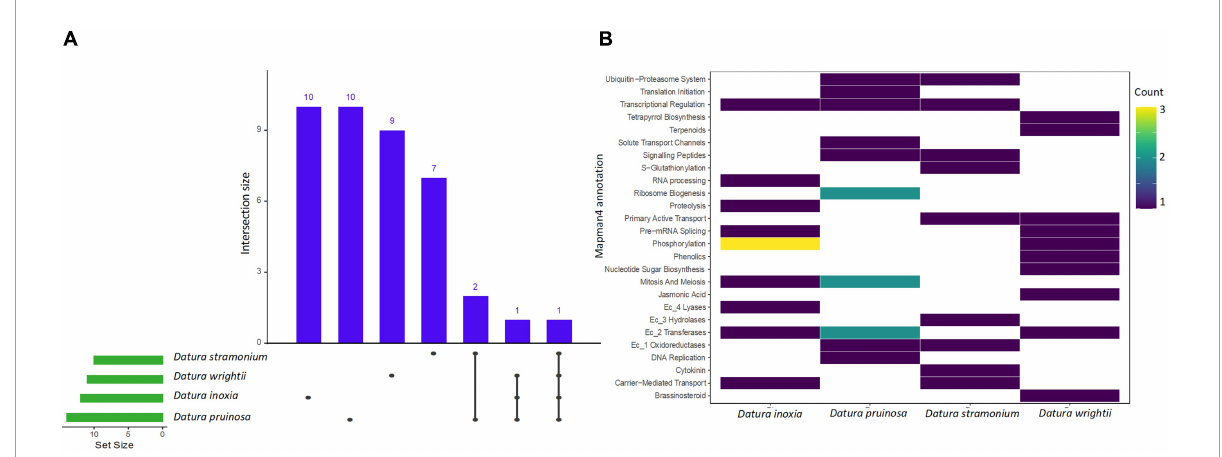
FIGURE2 The UpSet plot shows the intersections of the set of a particular expanded protein family annotated with Mapman4 from the seven transcriptomes. Filled cells indicate that the set is participating in the intersection and that the species share that protein family with signal of expansion (A) . Heatmap of the enriched expanded proteins of the four Datura species studied here (B) . The brightness of color indicates the number (counts) of enriched protein families with signal of expansion that are shared between species. See also Supplementary Tables 4 – 6 .